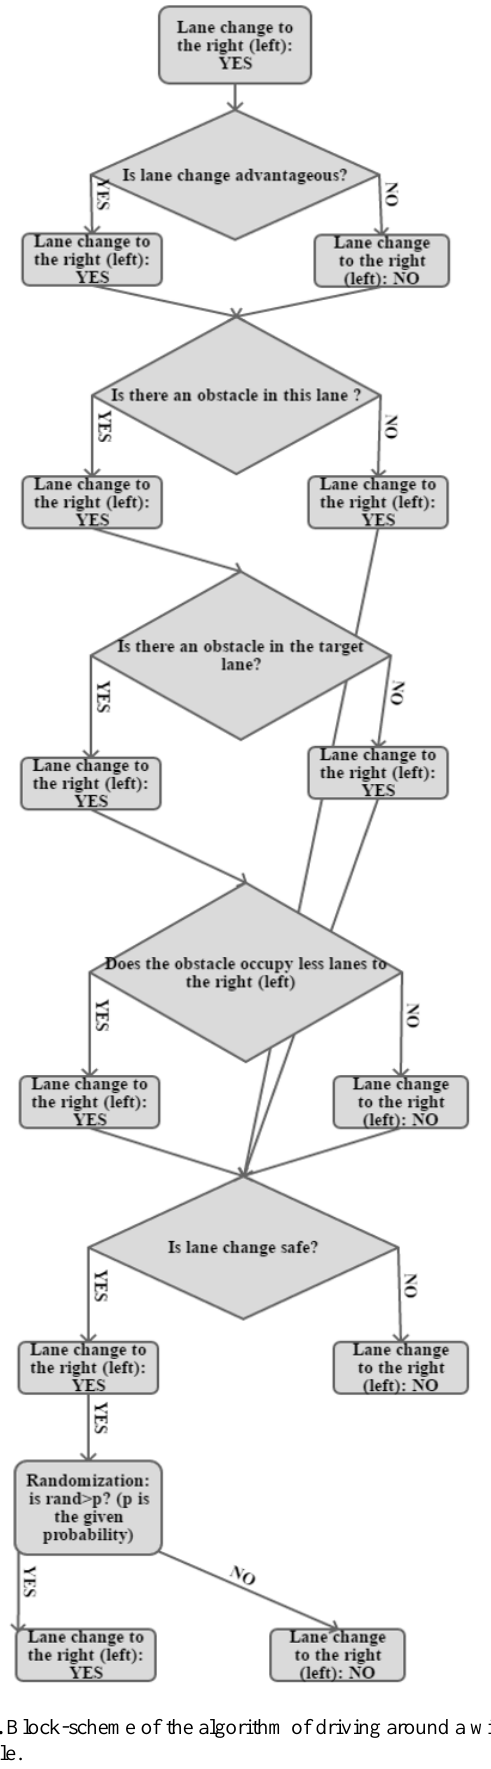
Fig. 5. Block-scheme of the algorithm of exiting a